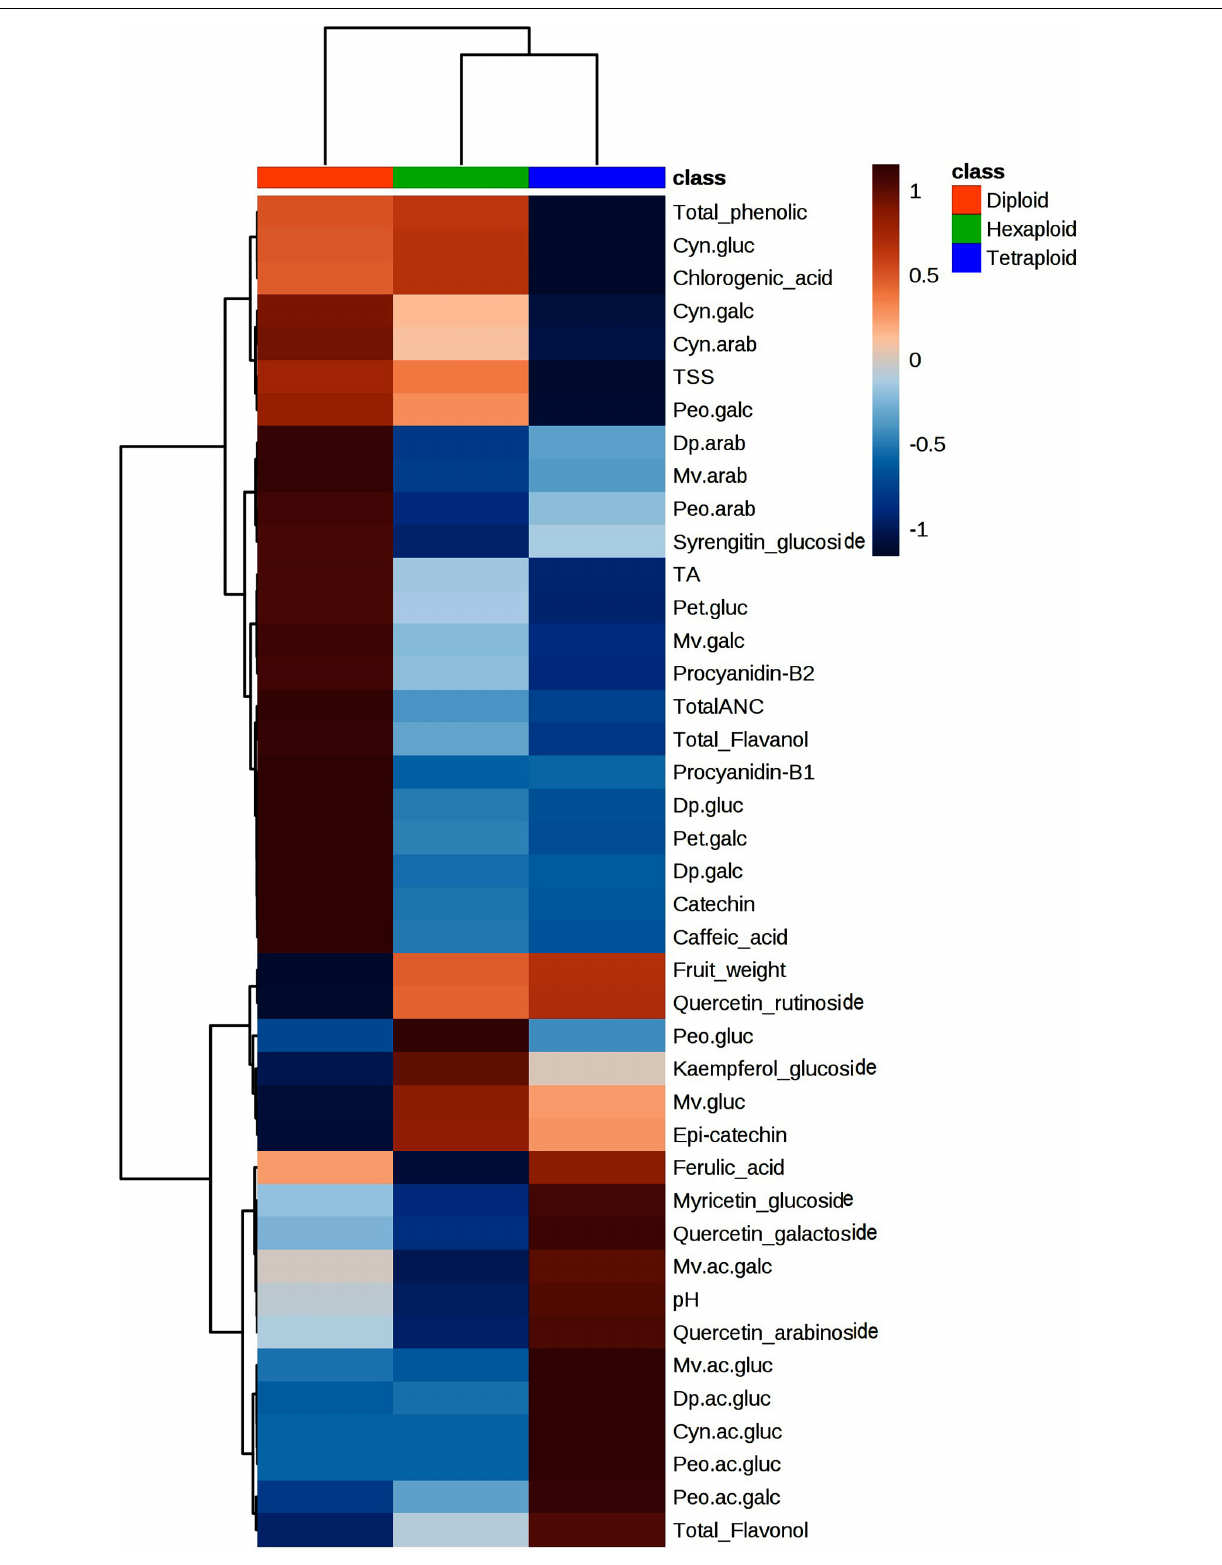
Frontiers in Plant Science |